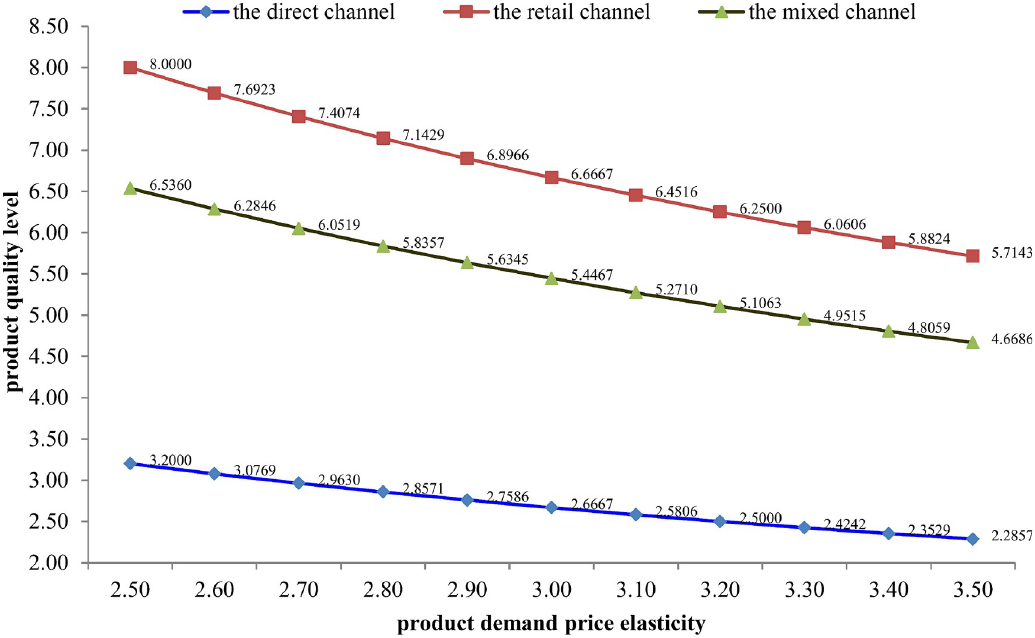
Fig 2. The product quality level in three types of distribution